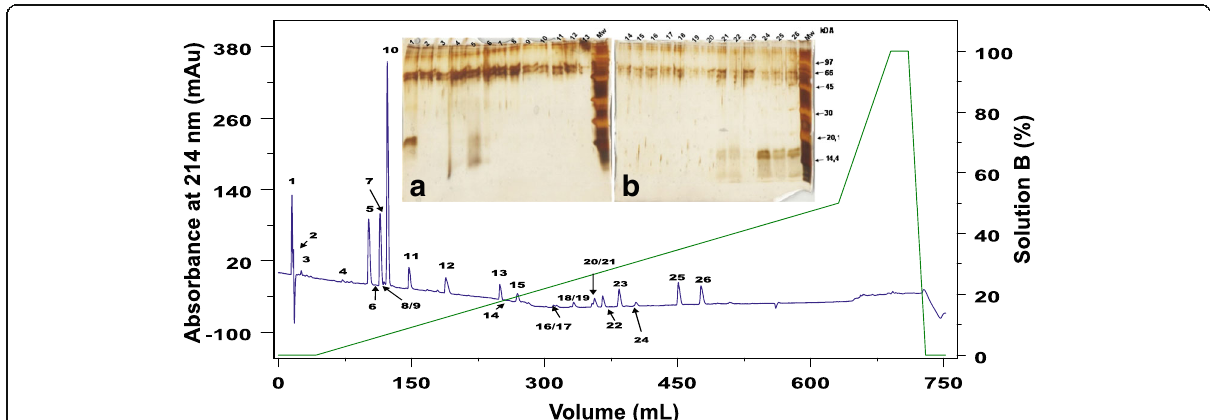
Fig. 2 Cutaneous secretion chromatogram in C18 column RP-FPLC and the SDS-PAGE profile of each fraction. The blue line represents the absorbance monitored at 214 nm and the green line represents the concentration of solution B. Each fraction was analyzed in SDS-PAGE stained with silver (insert figures). Insert figure a represents fractions CS1 to CS13 and insert figure b shows fractions CS14 to CS26. The wells at left show the low molecular weight marker from GE